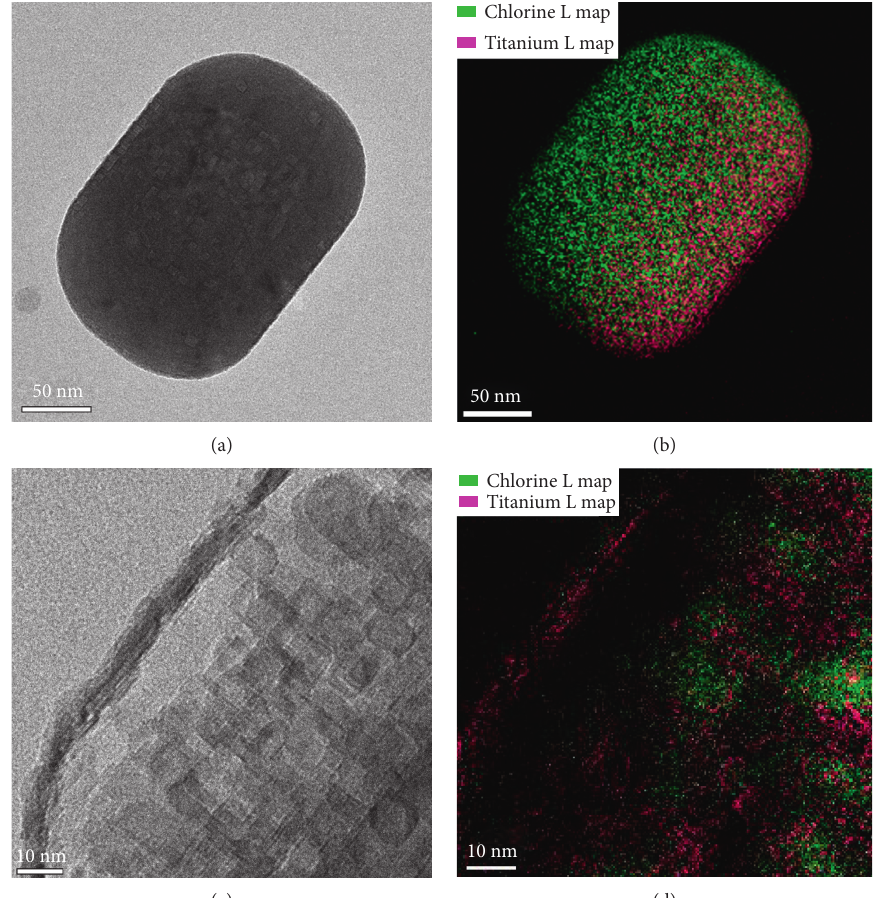
Figure 7: EFTEM-EELS high-resolution images of NaCl-TiO of TiO 2 surrounding the NaCl